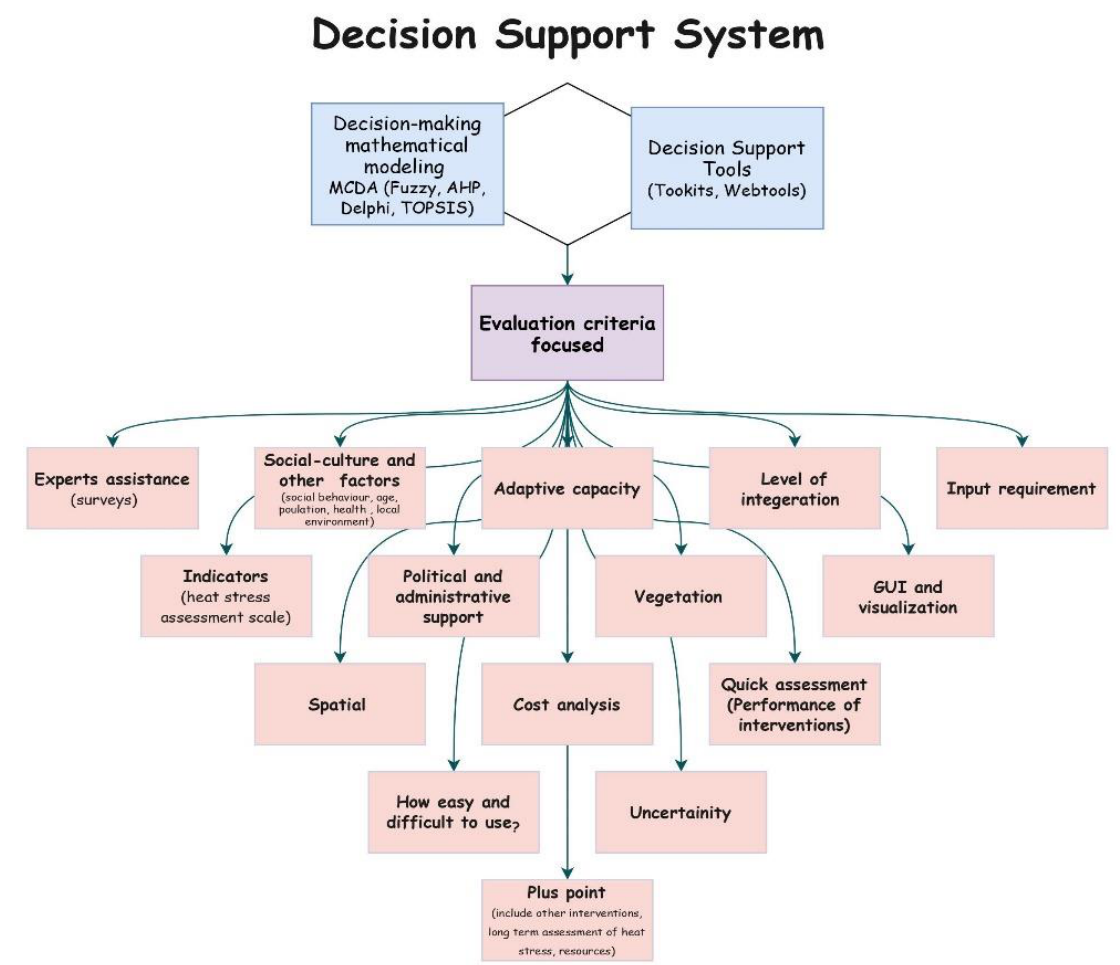
Figure 1. Methodology of the review paper.